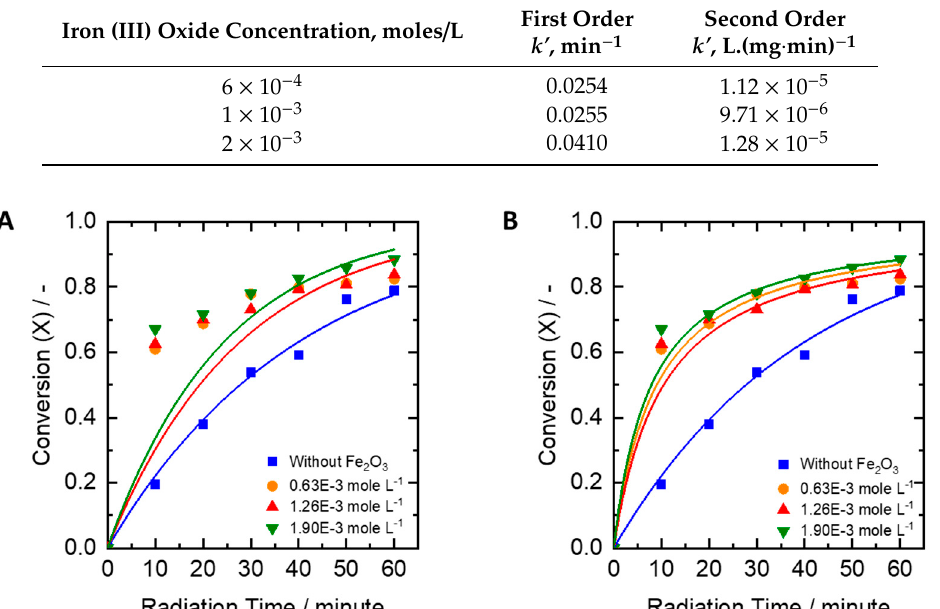
Table 3. Kinetic parameter of iron (III) oxide concentration variation. Iron (III) Oxide Concentration, moles / L